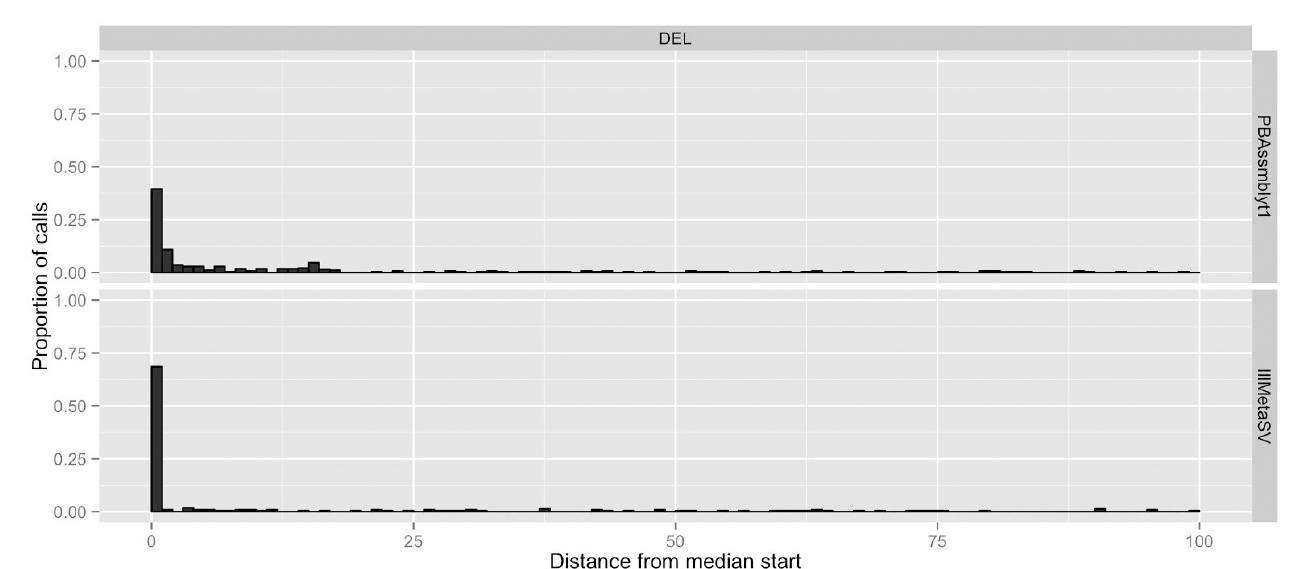
Figure 3. Histogram of distance from the median start position for deletion calls 400 to 999 bp in size for a PacBio-based Assemblytics callset and for an Illumina-based MetaSV callset. Only sites with calls from at least 4 different callsets were included in order to calculate a useful median value at each